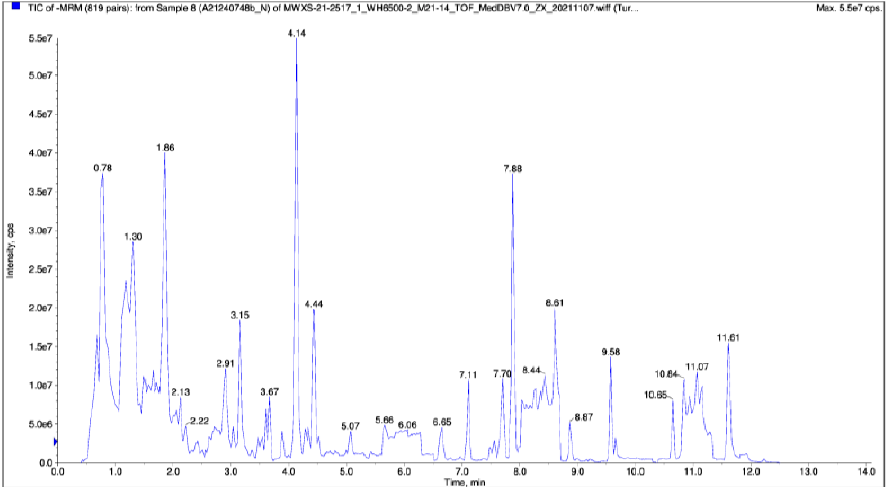
Figure 2. The total ions current (TIC) for the sample mass spectrometry. The abscissa was the retention time of the metabolite detection, and the ordinate was the ion current intensity of the ion detection (the intensity unit is count per second, cps).